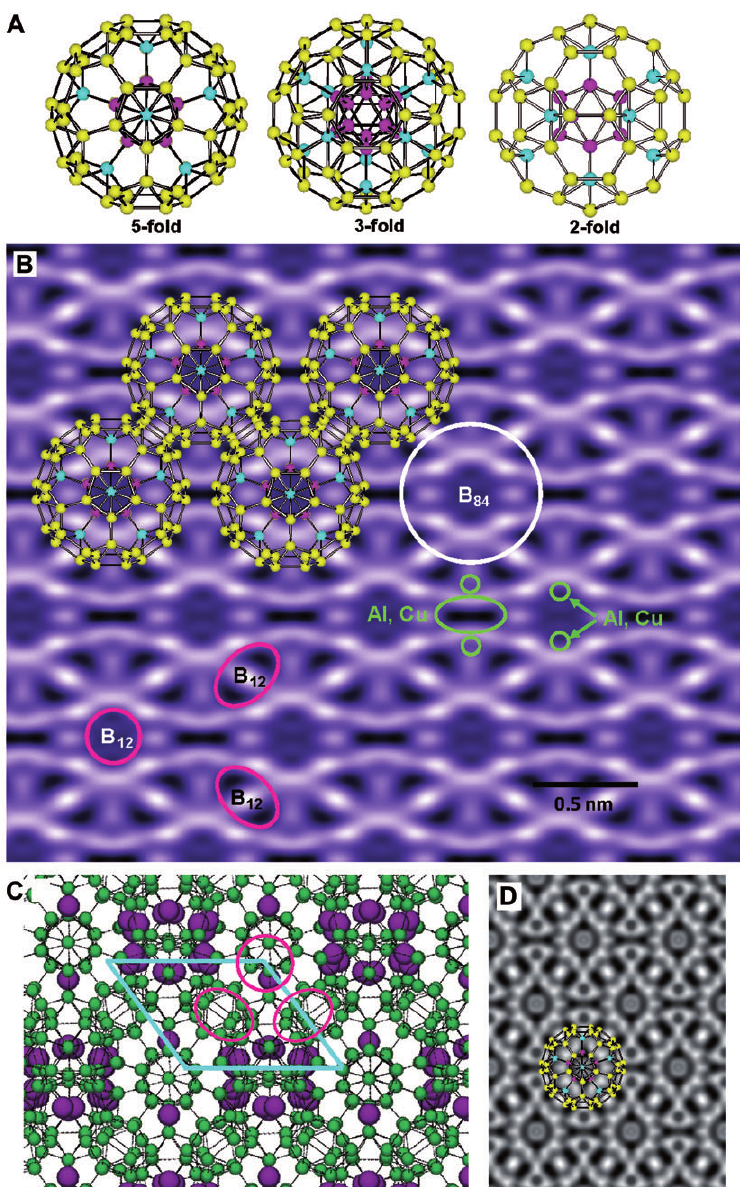
Figure 6 (A) HREM image of Al along the 5-, 3-, and 2-fold axes. (C) Structure models of